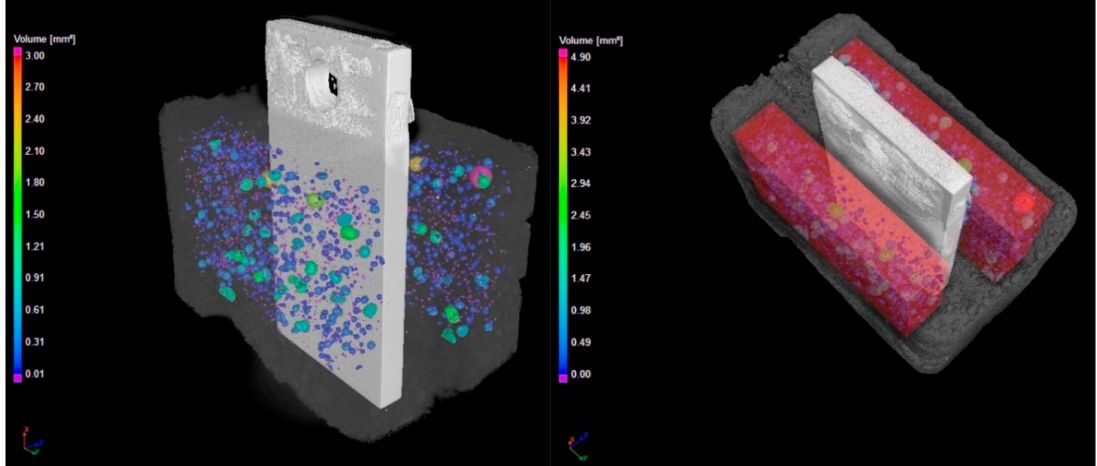
Figure 8. Computed tomography scan of steel/Variodur specimen in pristine form (control specimen). The pores are imaged (left ) and quantified in the red area (right